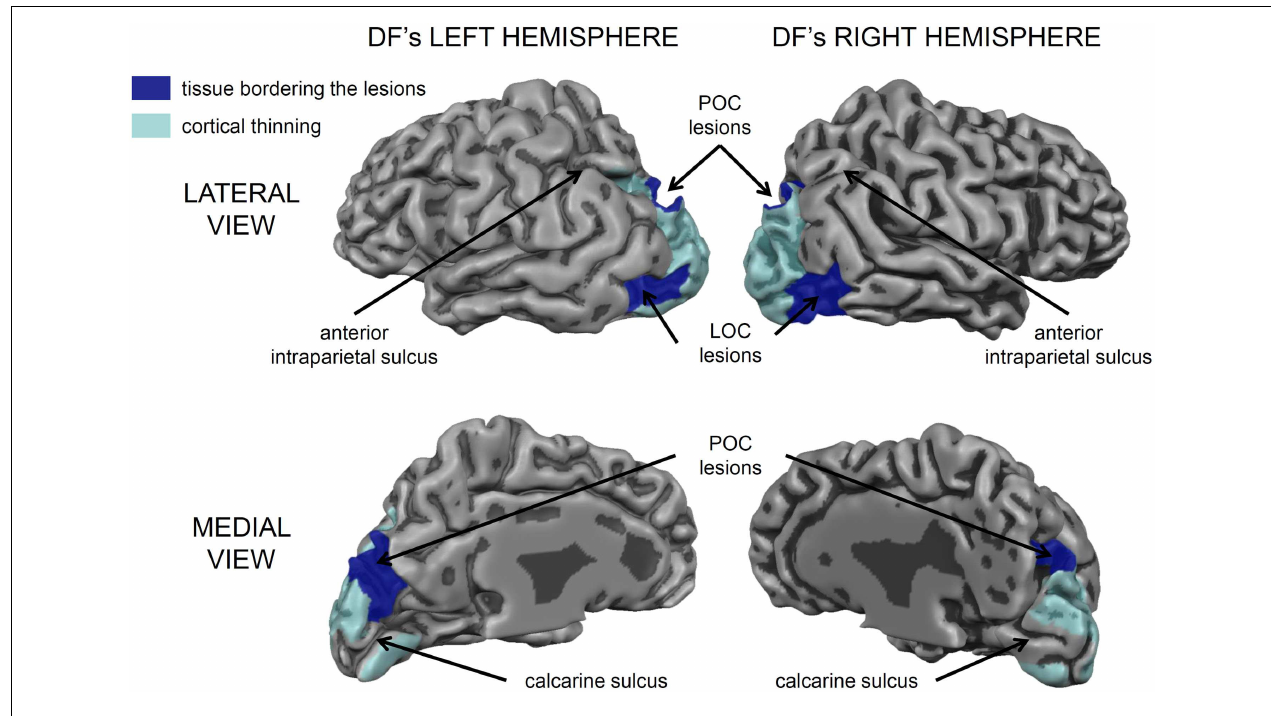
additional lesions in the parieto-occipital cortex (POC) marked in dark blue. Importantly, the cortical tissue surrounding most of the calcarine sulcus, corresponding to primary visual cortex (V1) is intact, as are most of the frontal, temporal, and parietal cortices.The small lesion in the anterior part of the upper bank of the calcarine sulcus in her left hemisphere accounts for the partial quadrantanopia in her lower visual field [see Ref. (10,